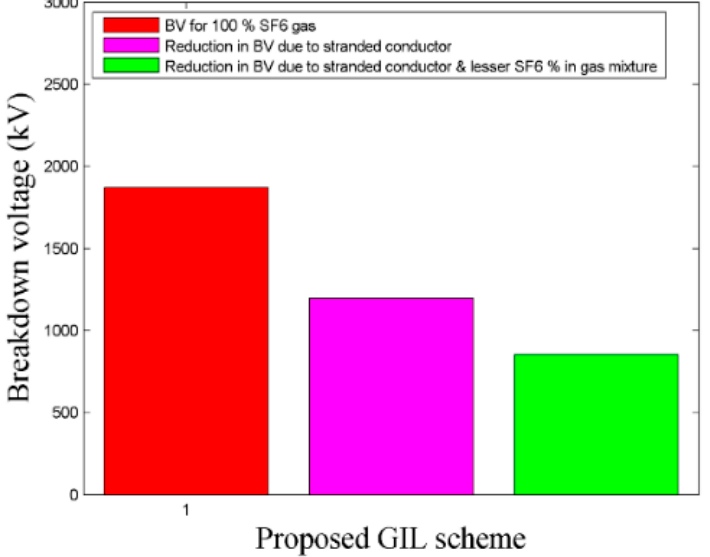
Figure 14. Breakdown voltage (BV) appraisal for the proposed FGIL scheme.